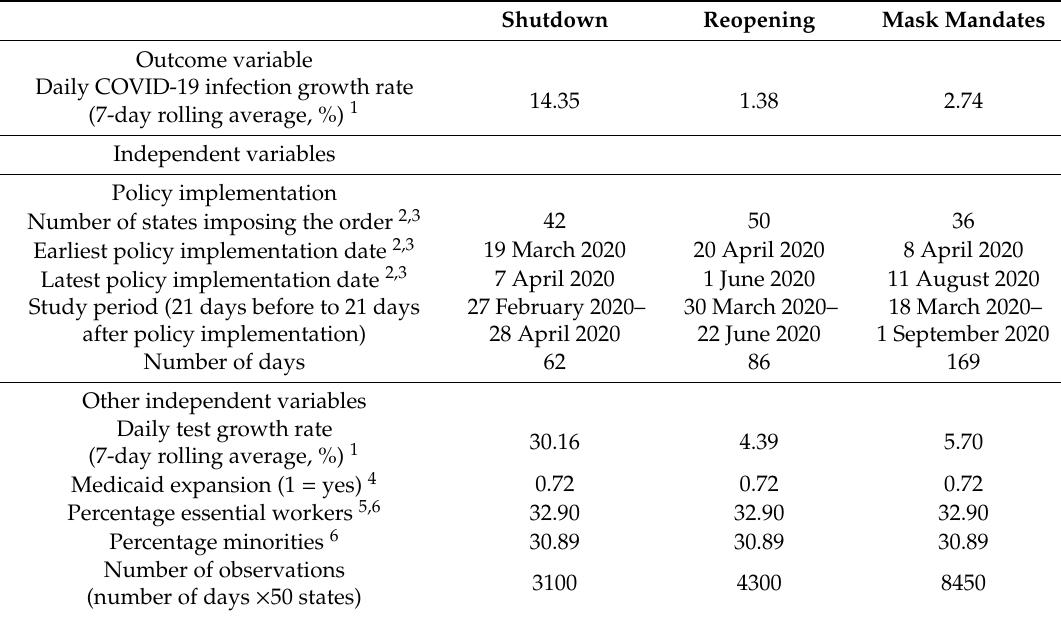
Table 1. COVID-19 state policy and descriptive statistics: 50 US